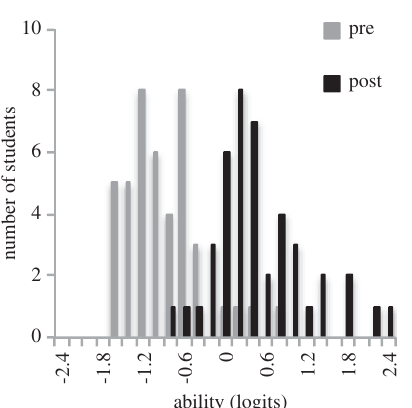
FIG. 22. The pre- and postability histogram for class 8.